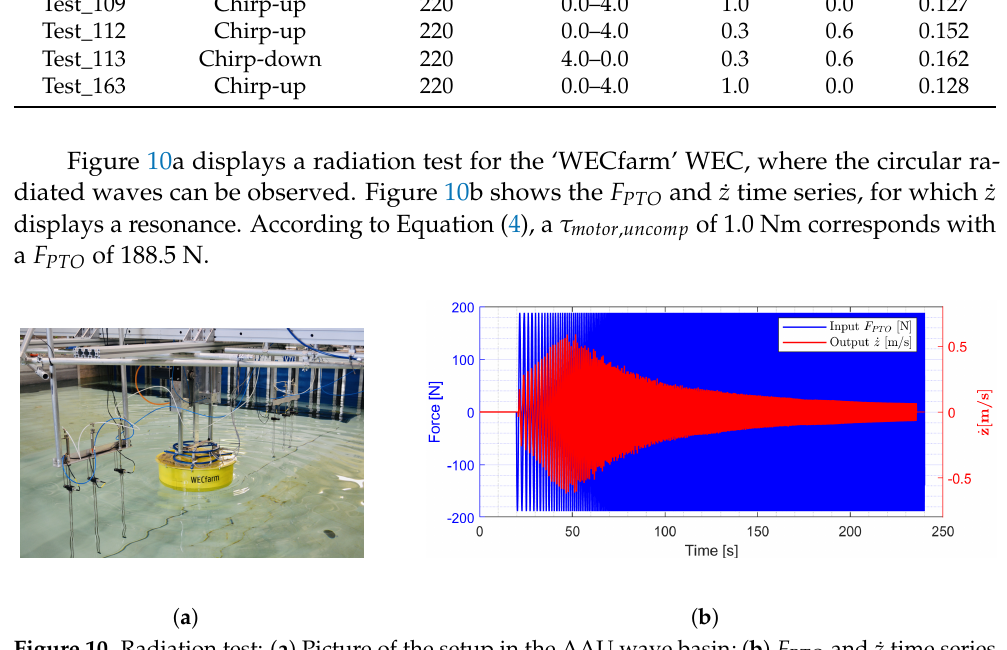
Figure 10. Radiation test: ( a ) Picture of the setup in the AAU wave basin; ( b ) F PTO and ˙ z time series